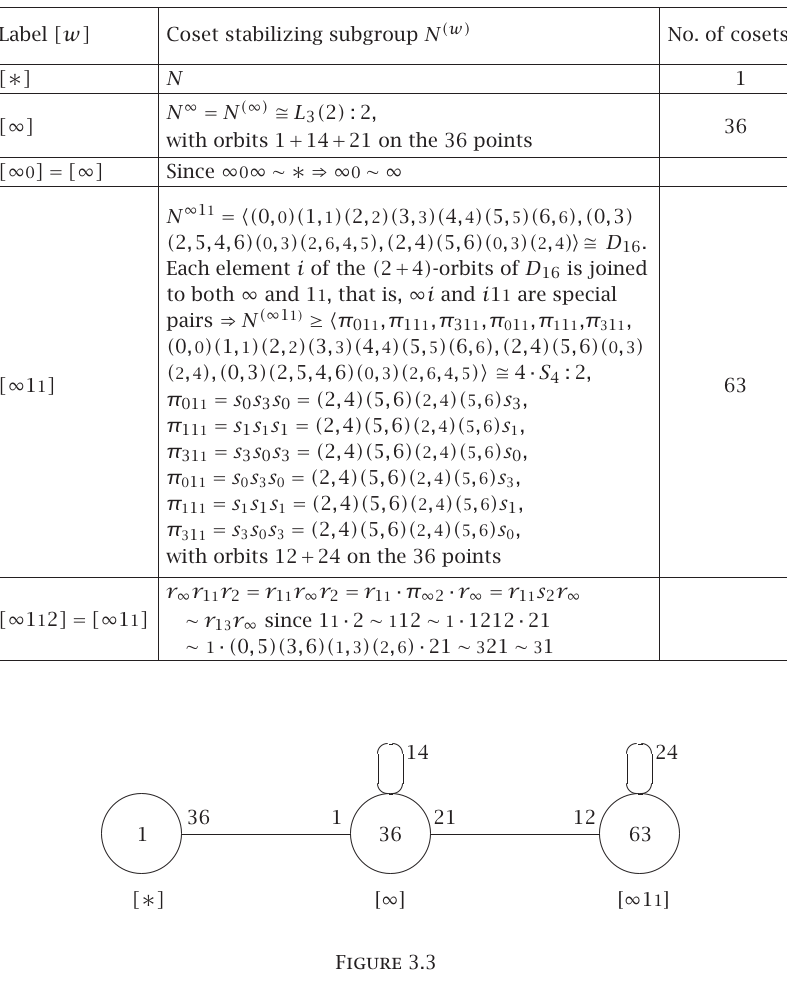
Table 3.2 . Double coset enumeration for J